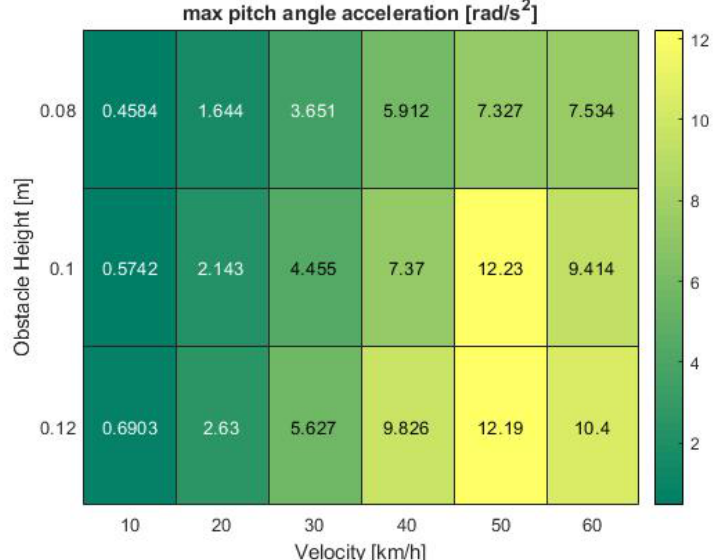
Figure 10. Pitch angle acceleration at various bump obstacle heights and vehicle velocities in the simulation.